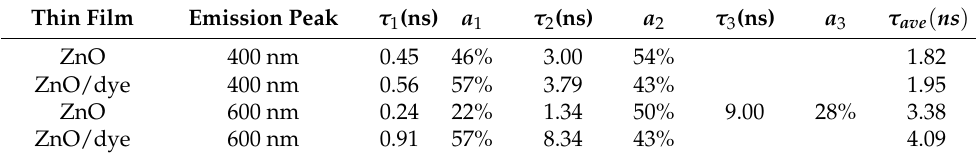
Figure 3. Normalized time-resolved PL spectra at emission peak of ( a ) 400 nm and ( b ) 600 nm of the zinc dross-originated ZnO nanoparticle films with (red-colored) and without (black-colored) dye adsorption. Table 1. Kinetic parameters of emission decay